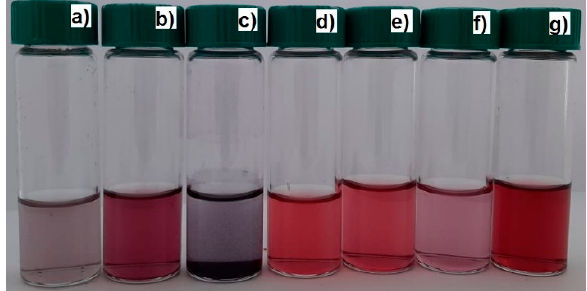
Figure 1. Photos of gold nanoparticle (AuNP) samples synthesized and stabilized using κ -carrageenan ( a ), PEG 40 kDa ( b ), gellan ( c ), PVP 10 kDa ( d ), PVP 40 kDa ( e ), pectin ( f ) welan ( g ) at 100 °C; [HAuCl 4 ] = 0.01 mM.